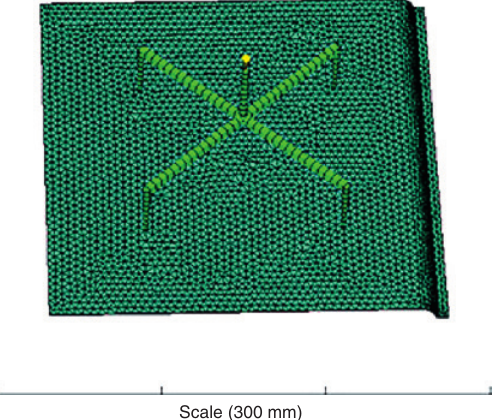
Figure 2: The finite element model of thin-walled part.